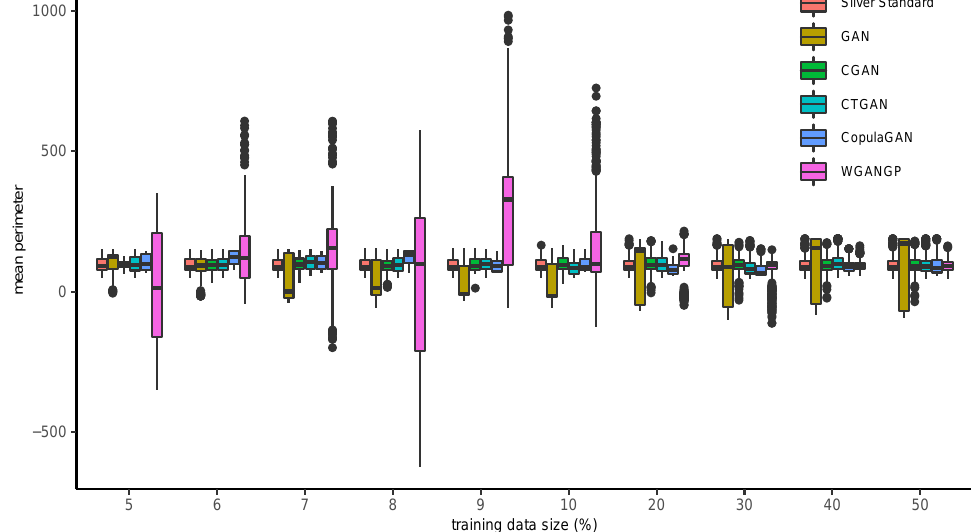
Figure 4. Mean perimeter of tumors, a key feature in synthetic data from GAN variants over 10 different samples, versus the size of the training data (in percent) using the